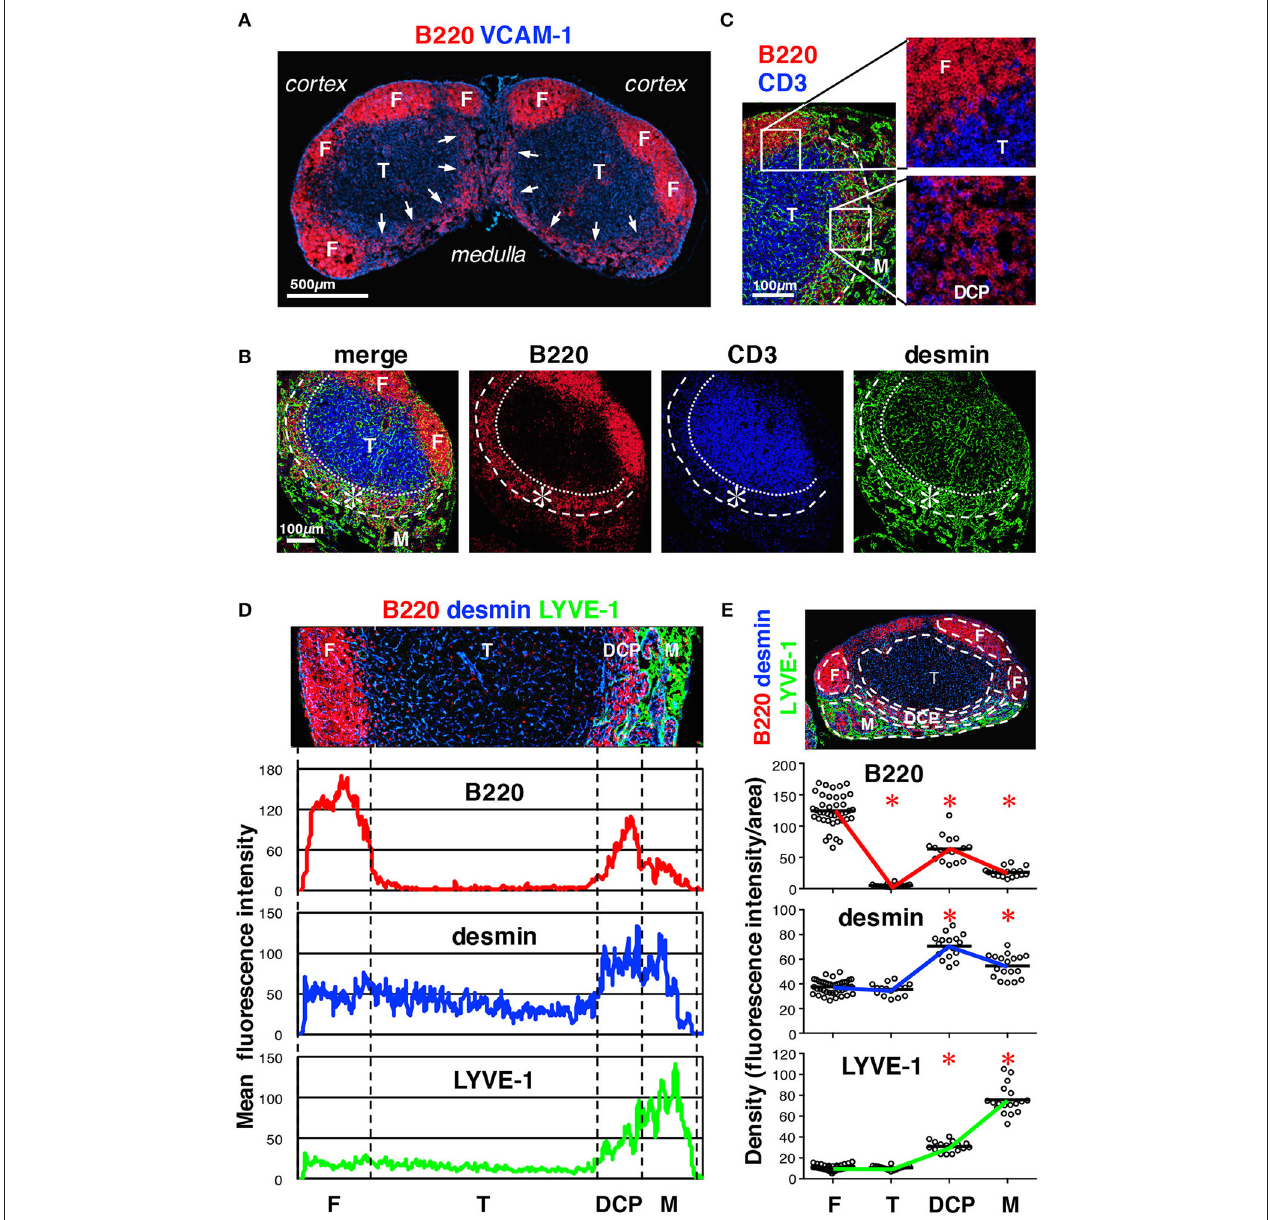
FIGURE 3 | Characterization of the DCP of mouse LNs. (A) Substantial B cell accumulation in the periphery of the deep cortex adjoining the medulla (inguinal LN, arrows). (B) The DCP is a belt-like zone surrounding the bottom of the T cell area (asterisks). (C) B and T cells were intermingled in the DCP (higher magnification view in the lower right), as compared to the superficial cortex, in which they were clearly segregated (upper right). Laminin signals are eliminated in the right micrographs. (D) Enrichment of desmin correlated with B cell accumulation in the DCP. Average fluorescent intensity profiles of B220, desmin, and LYVE-1 along the cortex–medulla axis. Desmin signals were also high in the medulla. (E) Quantitative analysis of signal densities in LN subcompartments. The micrograph is representative of the region of interest (ROI) from the image data. Marker densities in each region are plotted (open circles) in the lower graphs (bars, mean; asterisks, significantly different compared to the follicles, p <